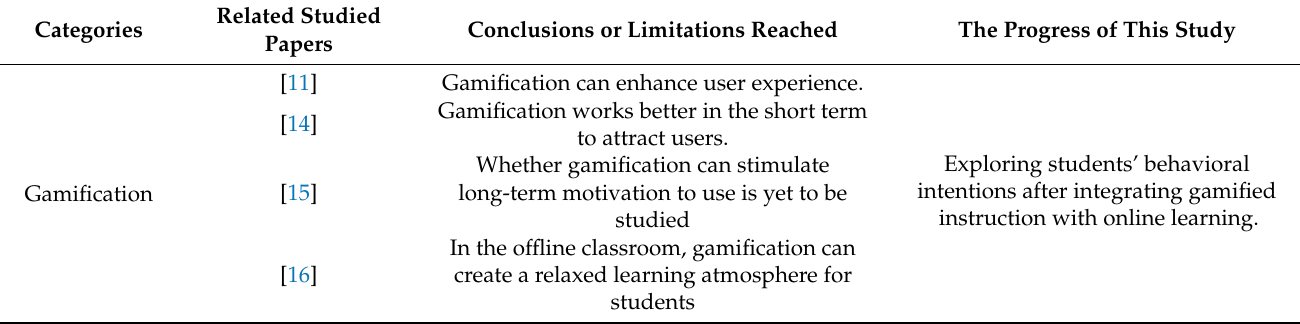
Table 1. Comparison with existing